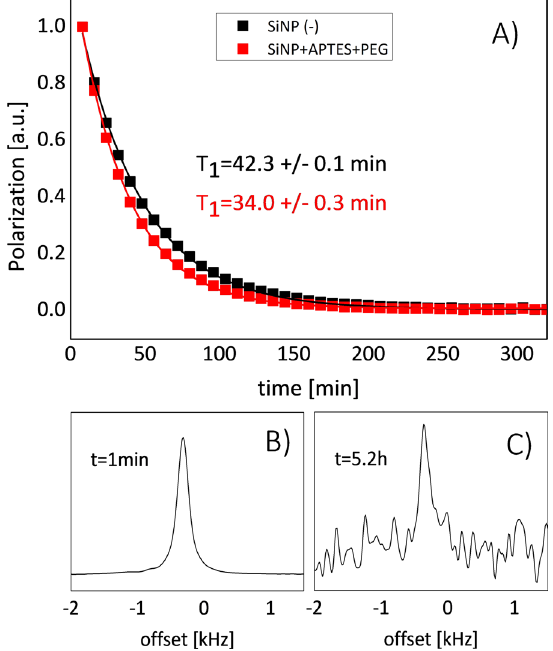
Figure 3. ( A ) Comparison of T 1 relaxation between pure (black) and PEG functionalized (red) silicon nanoparticles. The Fourier-transformed FID signal acquired at t = 1 min ( B ) and t = 5.2 h ( C ) at room temperature using a 9.4 T imaging system.